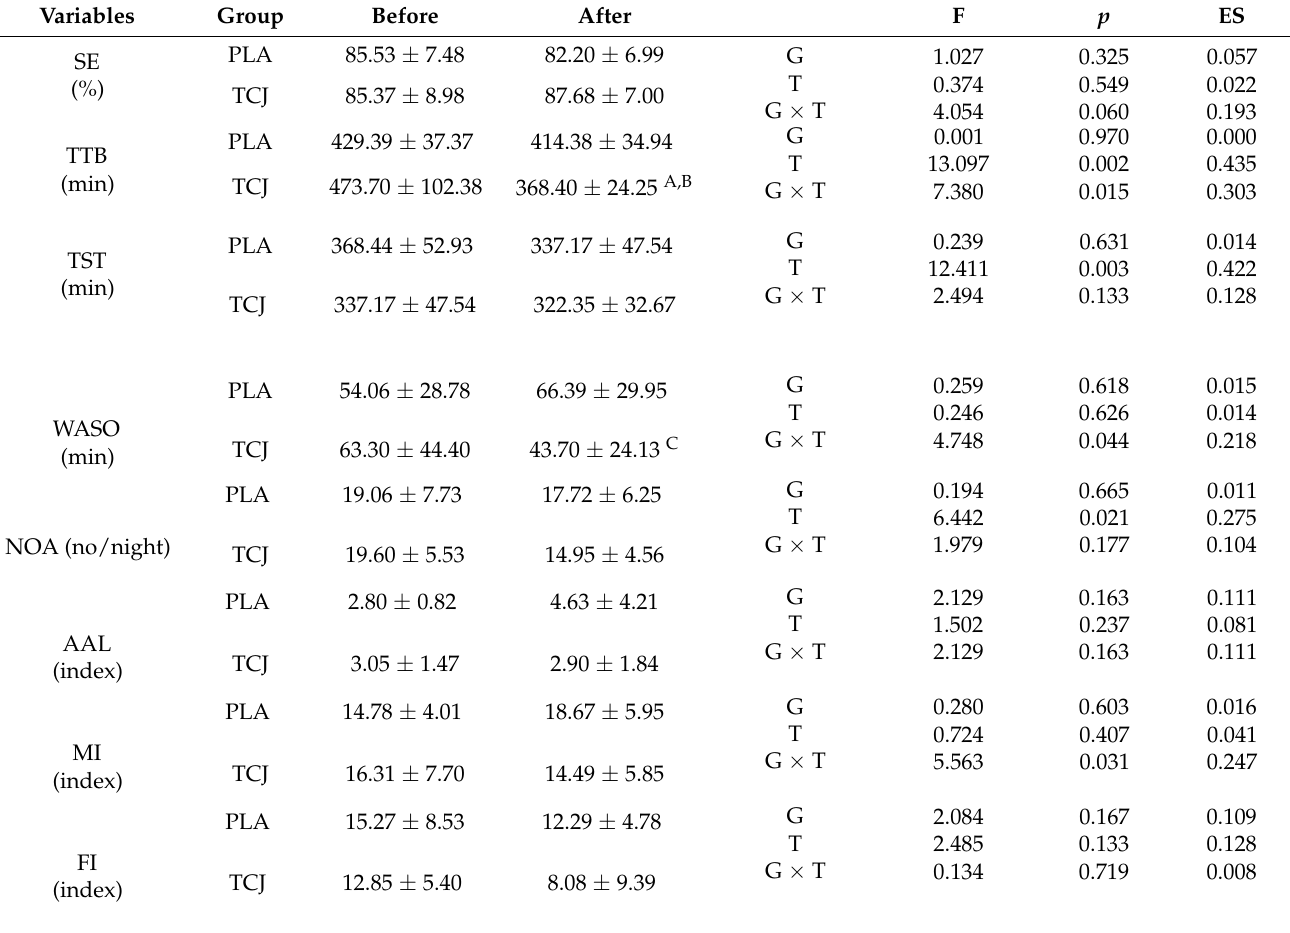
Table 3. Change in sleep quality variables as per